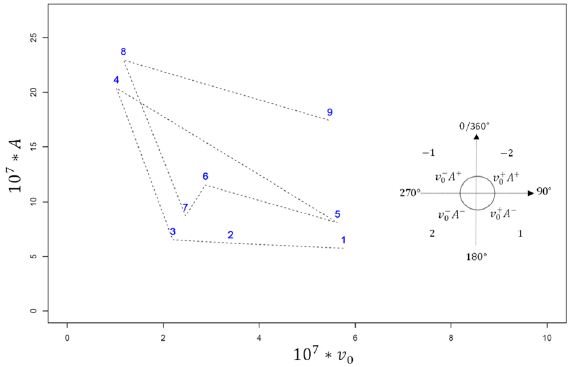
Figure 4. Example of a phase plane of v 0 and A , representing variations of A as a function of v 0 , rescaled by 10 7 for clarity. Numbers (1 to 9) on the curve are days of sampling. A score s i → i + 1 is assigned to the variation from day d i to day d i + 1 , for i ∈ { 1, . . . , 8 } . The small plane on the right-hand side of the graph illustrates the assignment of scores. The score of − 2 is assigned to v + 0 A + describing an increase in both variables, a score of − 1 is assigned to v − 0 A + , i.e. decreasing v 0 and increasing A , a score of 1 is associated with v + 0 A − describing increasing v 0 and decreasing A , and finally 2 for the decrease in both variables. Each score is then weighted by ω i → i + 1 the relative Euclidian distance between days d i and d i + 1 , calculated as the Euclidian distance between the 2 days divided by ( d i + 1 − d i ). For this curve the set of scores can be written {− 1 ω 1 → 2 ,− 1 ω 2 → 3 ,− 1 ω 3 → 4 ,1